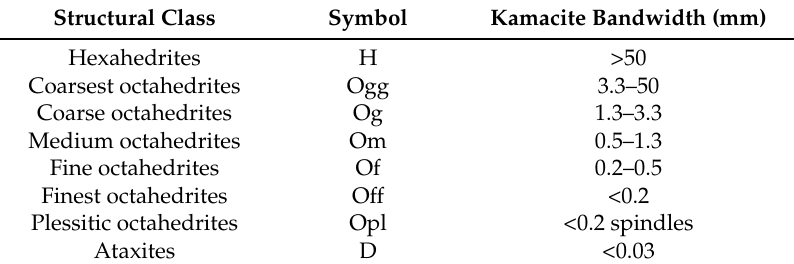
Table 1. Structural classification of iron meteorites (data from